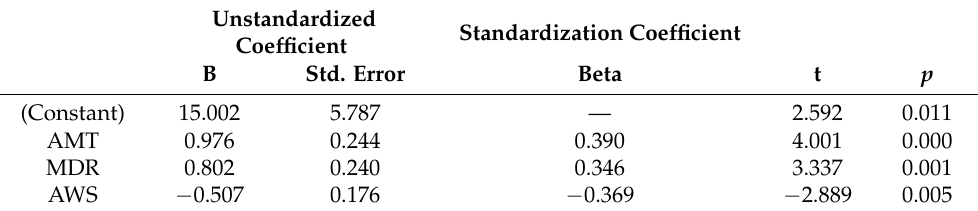
Table 3. Fit parameters for roof slope regression model. Unstandardized Standardization Coefficient Coefficient B Std. Error Beta t